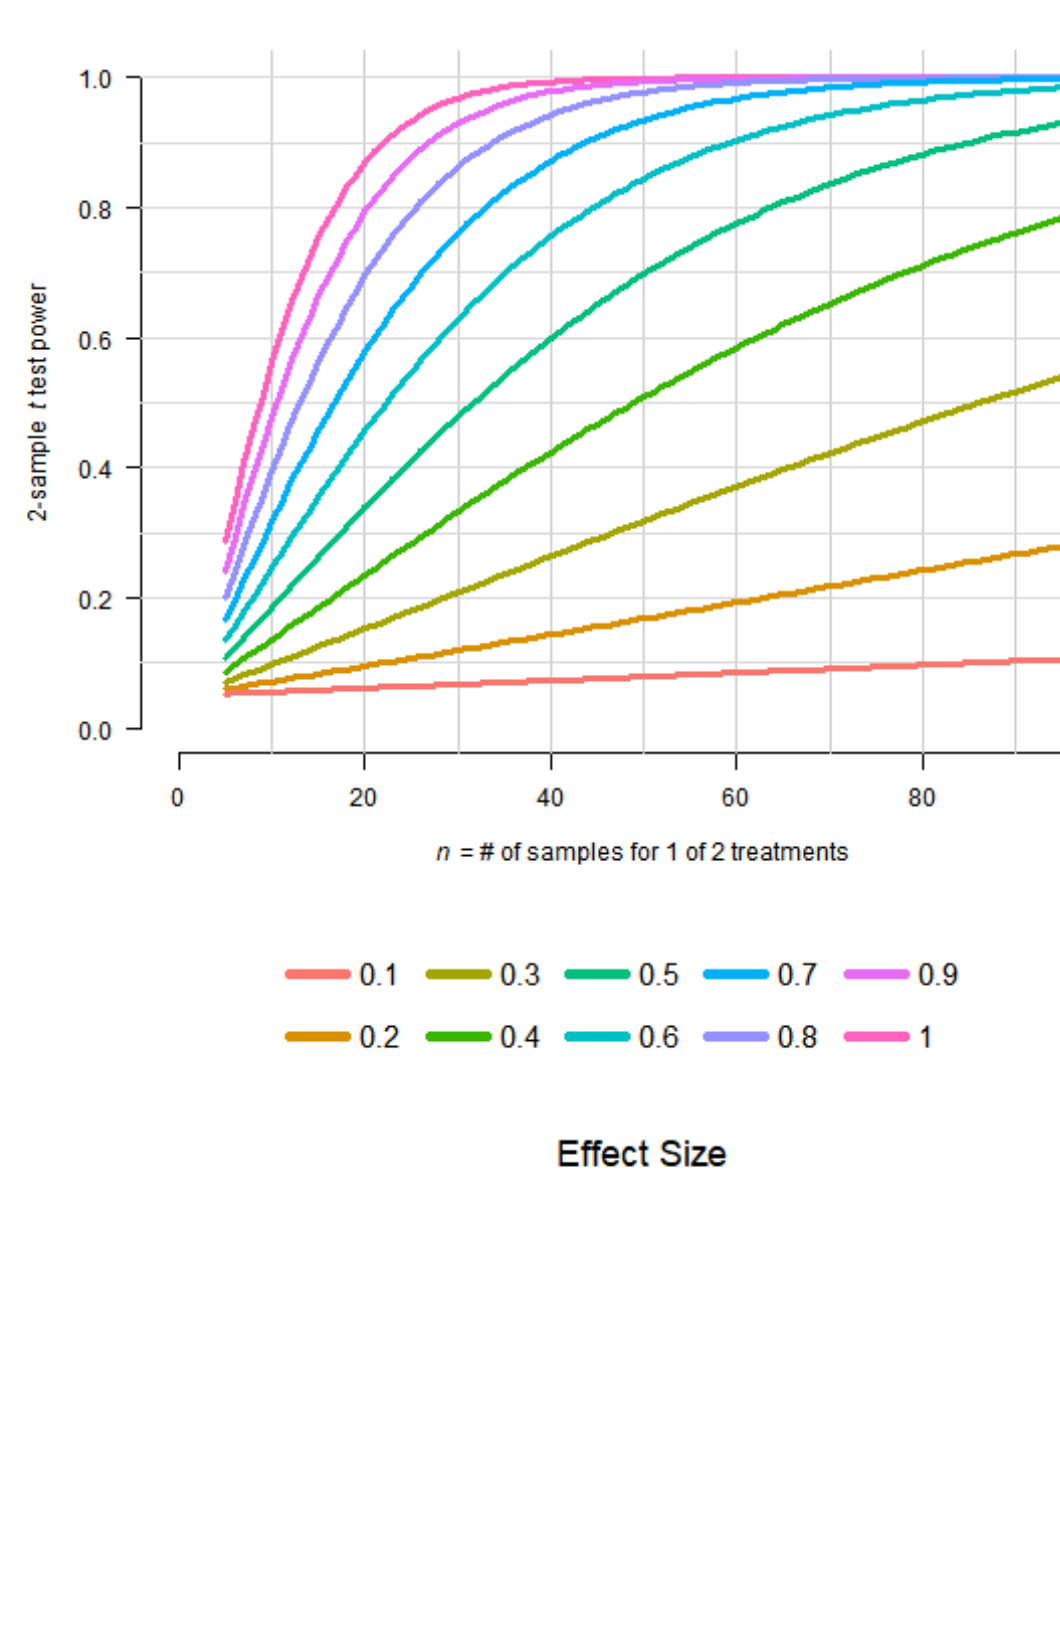
Figure 1. For effect sizes ranging from 0.1 to 1.0, power of a 0.05 level two-sample t test plotted by n , the number of samples in one treatment group. Total sample size is assumed to be 2n